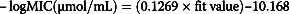
Synthesis of the ketones 3a-d. Reagents and conditions: i) HN(CH3)2HCl, (CH2O)n, conc. HCl, ethanol, reflux, 2 h; 47-95% yield ii) Imidazole, water, reflux, 5 h, 44-77% yield.